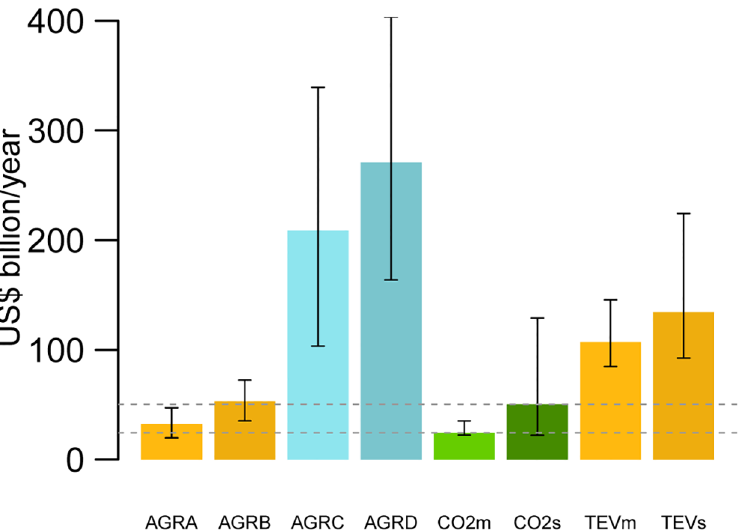
Fig 1. Comparison (2000–2012) of the annual agricultural value gained on deforested land versus externalities consisting of carbon emission and lost ecosystemservices(ES) value. AGRA, AGRB, AGRC, AGRD: medianagriculturalrents generated under scenariosA, B, C, and D respectively.CO 2 m and CO 2 s: medianvalue of carbon emissionsat market and social price levels, respectively. TEV: total ecosystem service value. TEVm and TEVs: median value of TEV includingcarbonemissionsat market and social price levels, respectively. Error bars indicatethe 2.5th and 97.5th percentilesof the uncertainty distributionof outcomes. Dotted horizontallines denote the medianof carbon emissionsexternalitiesunder market and social